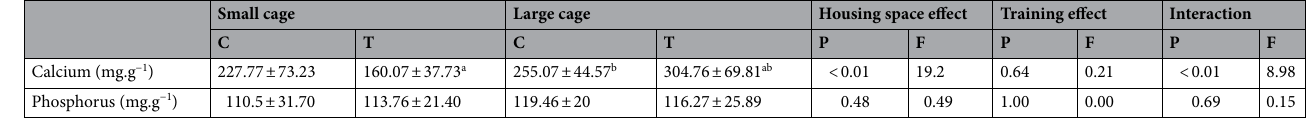
Table 3. Calcium and phosphorus values (mg.g −1 ) for the femur of the animals in the control (C) and trained (T) groups kept in small cage (SC) and large cage (LC). Calcium and phosphorus data in mg per gram of bone ash weight are in mean ± standard deviation (SD). Statistical analysis: Two-way Anova was used for identifying the effects of housing space and training, and Post-hoc Newman Keuls was used to trace differences among groups. Statistical significance symbols: a- different from SC-C, b- different from